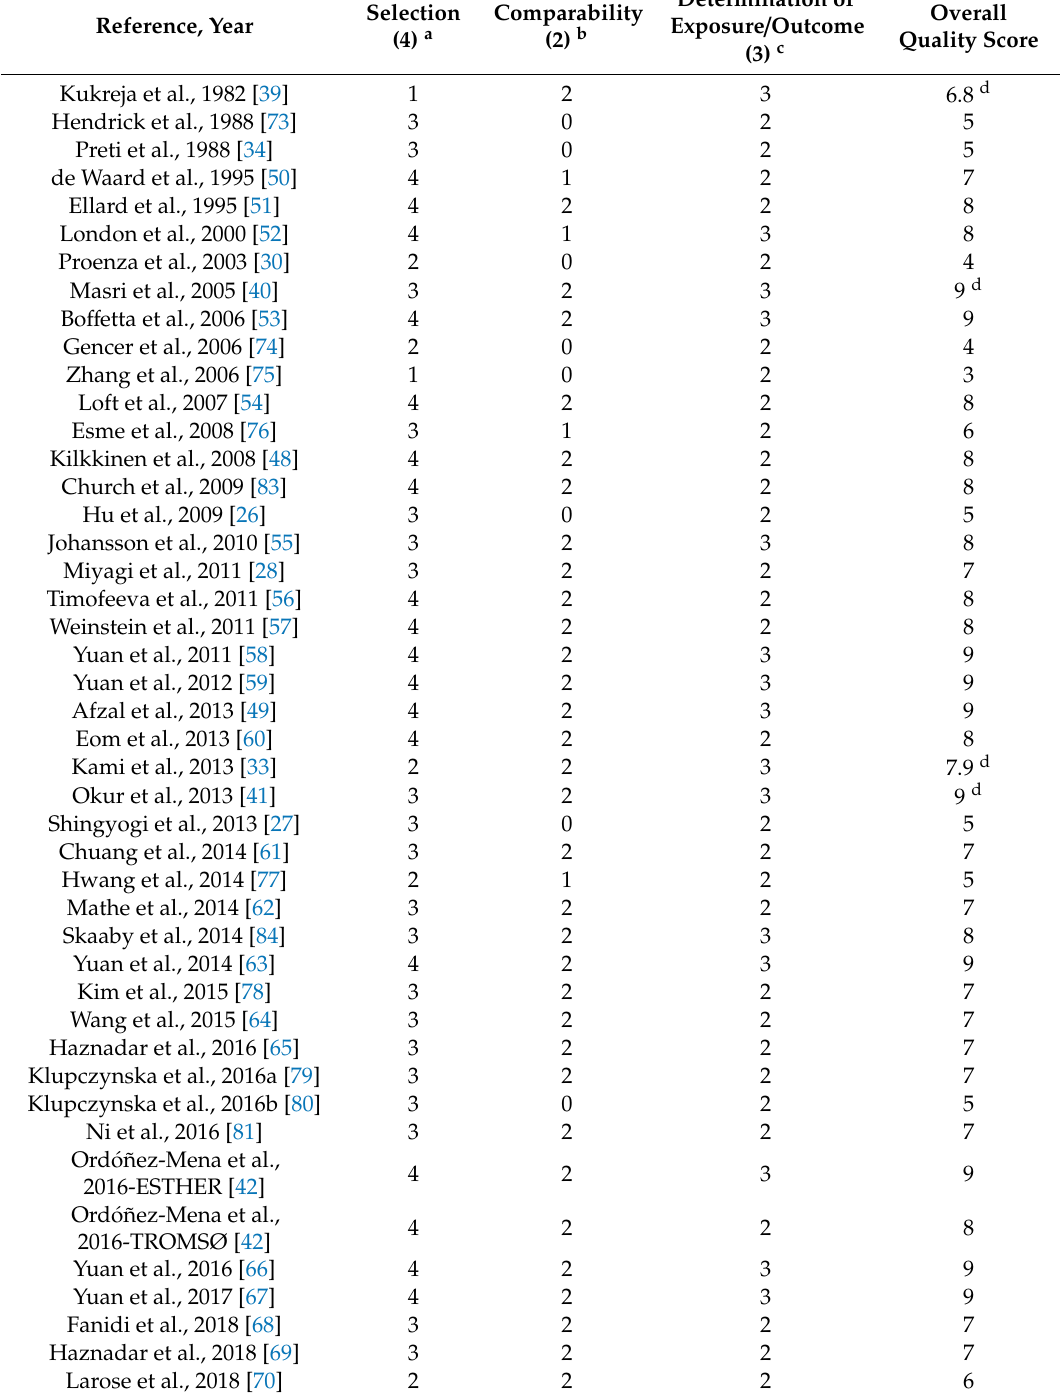
Methodological quality assessment of included studies (n = 53) using a 9-point Newcastle–Ottawa